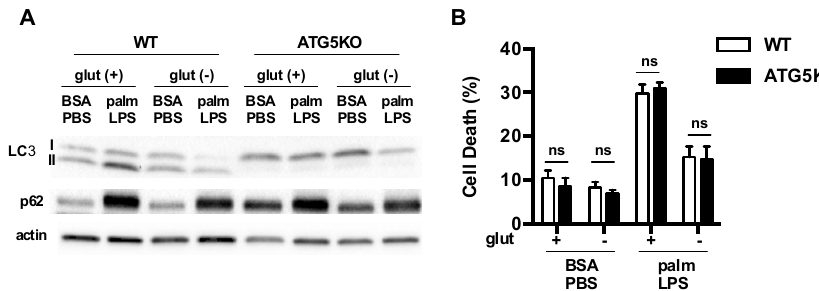
Figure 8. Autophagy is dispensable for protective effects of glutamine deficiency. ( A ) Primary macrophages were isolated from WT (ATG5 flx/flx) or ATG5KO (ATG5 flx/flx ‐ LysM ‐ Cre) followed by stimulation with BSA ‐ PBS or palm ‐ PLS in the presense or absence of glutamine. The levels of LC3 and p62 protein protein expression were assessed by western blotting. Actin is shown as a protein loading control; ( B ) pMACs from WT and ATG5KO mice were stimulated as indicated and cell death was determinded at 30 h using annexin-PI flow cytometry. The bar graph reports the mean ˘ SE for a minimum of 3 experiments, each performed in triplicate. *, p < 0.05 for WT vs .